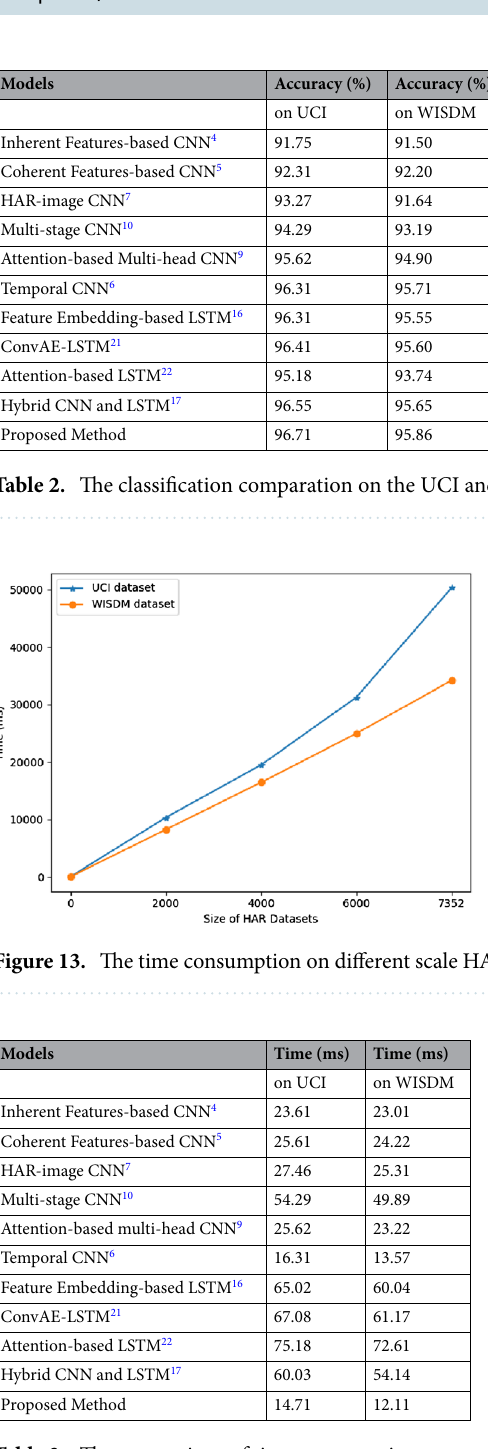
Table 3. The comparison of time consumption among models on the UCI and WISDM